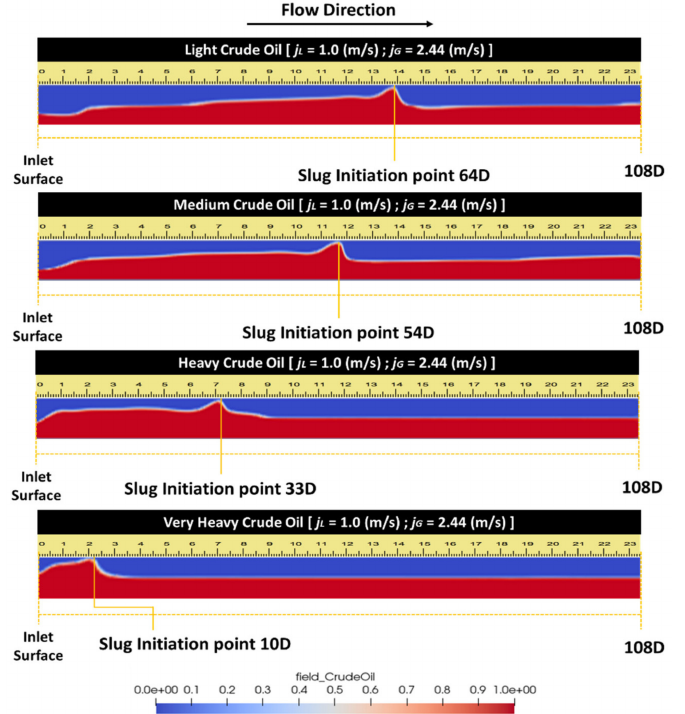
Figure 10. Effect of varying crude oil grades on slug initiation position (‘D’ represents the pipe